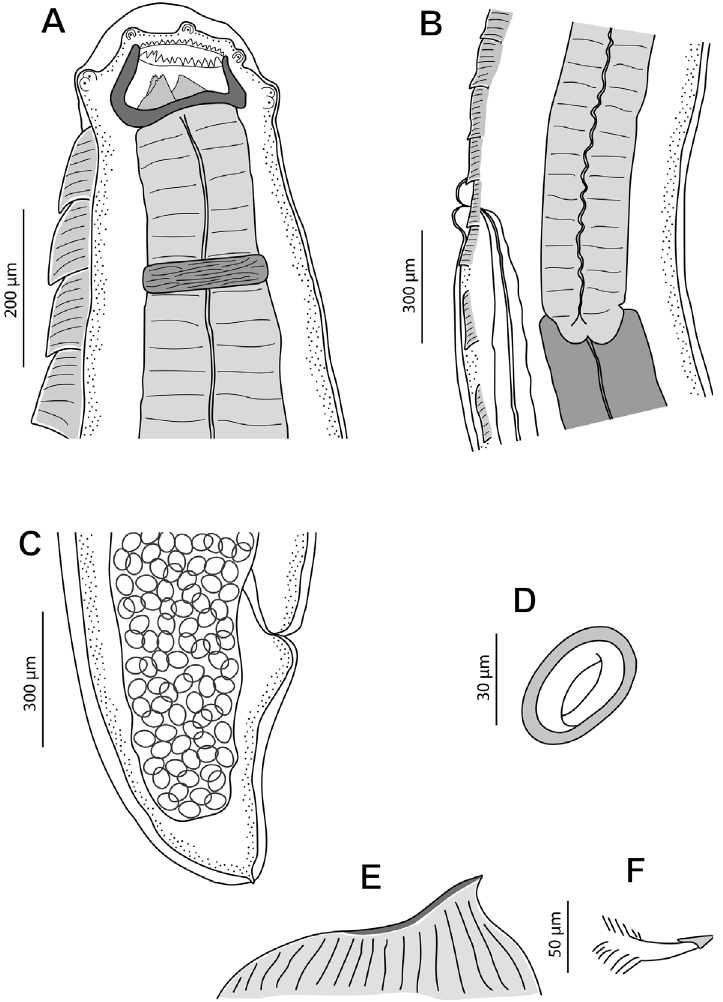
Figure 4. Pterygodermatites ( Mesopectines ) valladaresi n. sp., female. (A) Cephalic extremity, lateral view; (B) detail of vulvar region, lateral view; (C) tail, lateral view; (D) embryonated egg; (E) detail of a prevulvar cuticular comb (pair 21); (F) detail of a postvulvar cuticular spine (pair